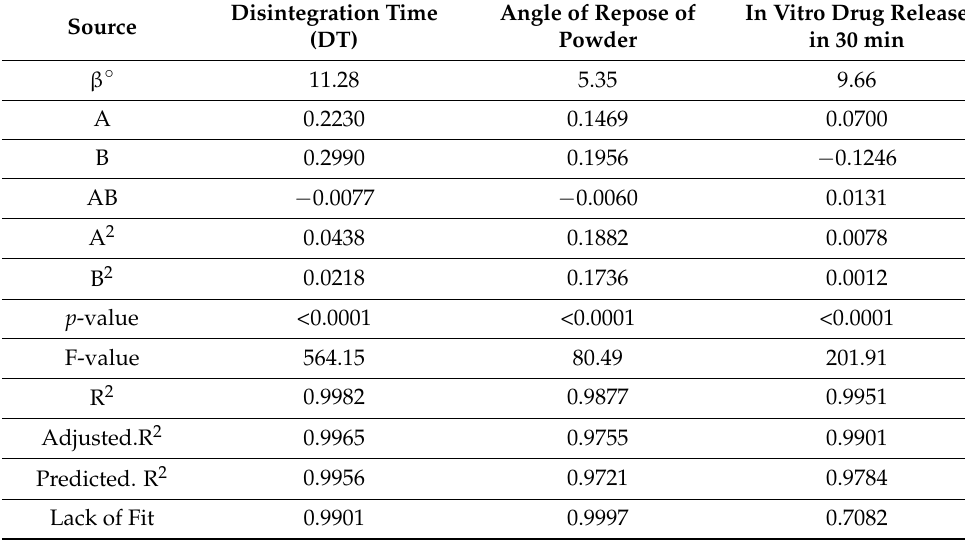
Table 5. Regression coefficient and ANOVA of independent